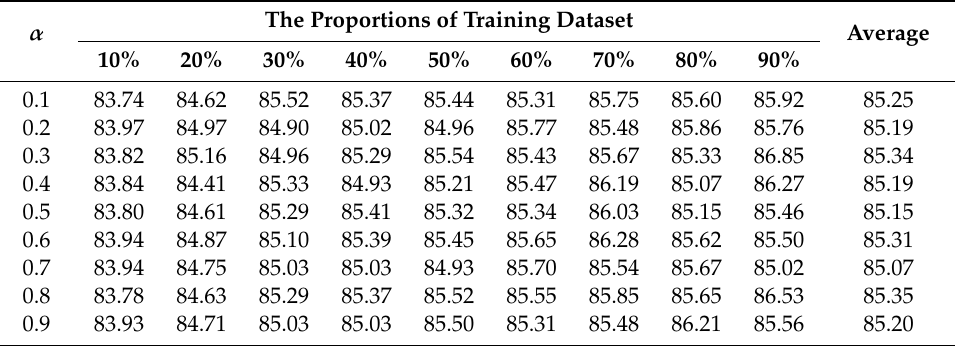
Table 9. In fl uence of triplet weight on the SDBLP dataset. Table 9. Influence of triplet weight on the SDBLP dataset.